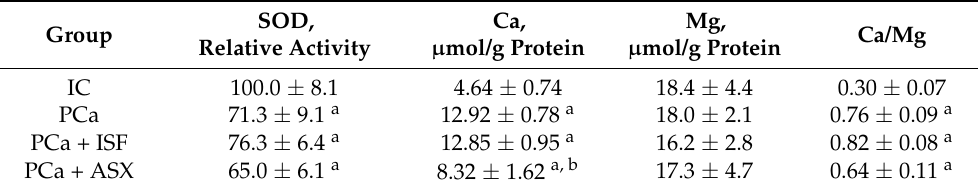
Table 3. Dorsolateral prostate tissue biochemistry in rats with prostate carcinogenesis treated with 163 ISF and ASX.